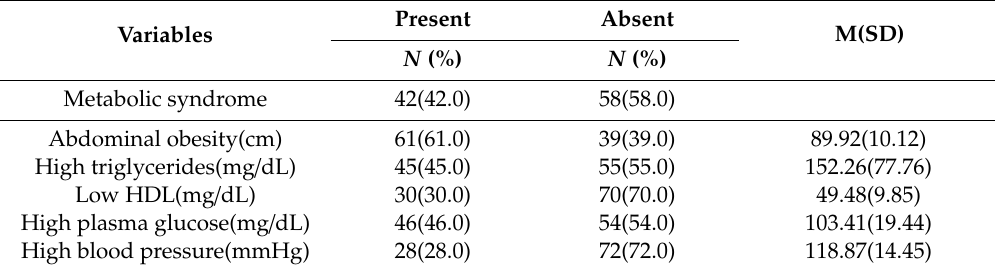
Table 1. Prevalence of metabolic syndrome and its components ( N =